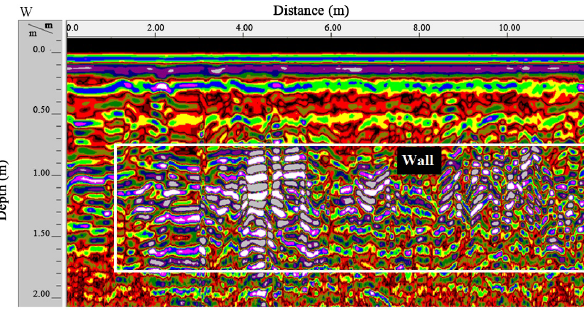
Figure 2. Hyperbolic reflections caused by pottery pipe is used to obtain the wave velocity with the equation of hyperbola.